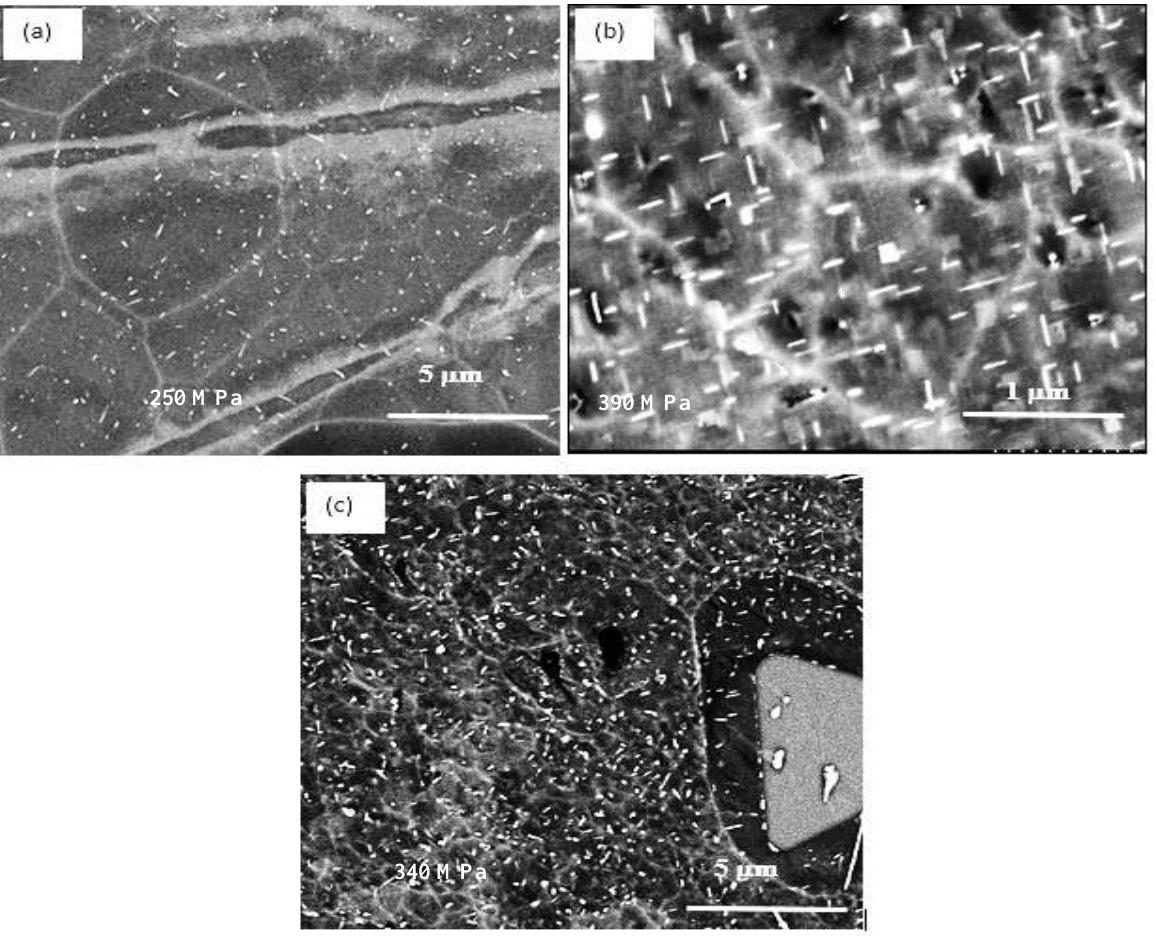
Figure 8. Variation in precipitates density and morphology as a function of applied heat treatment in alloy B: ( a ) as cast (condition 1); ( b ) T6 (condition 5); ( c ) T7 (condition 7) — Numbers in each image indicate UTS values.